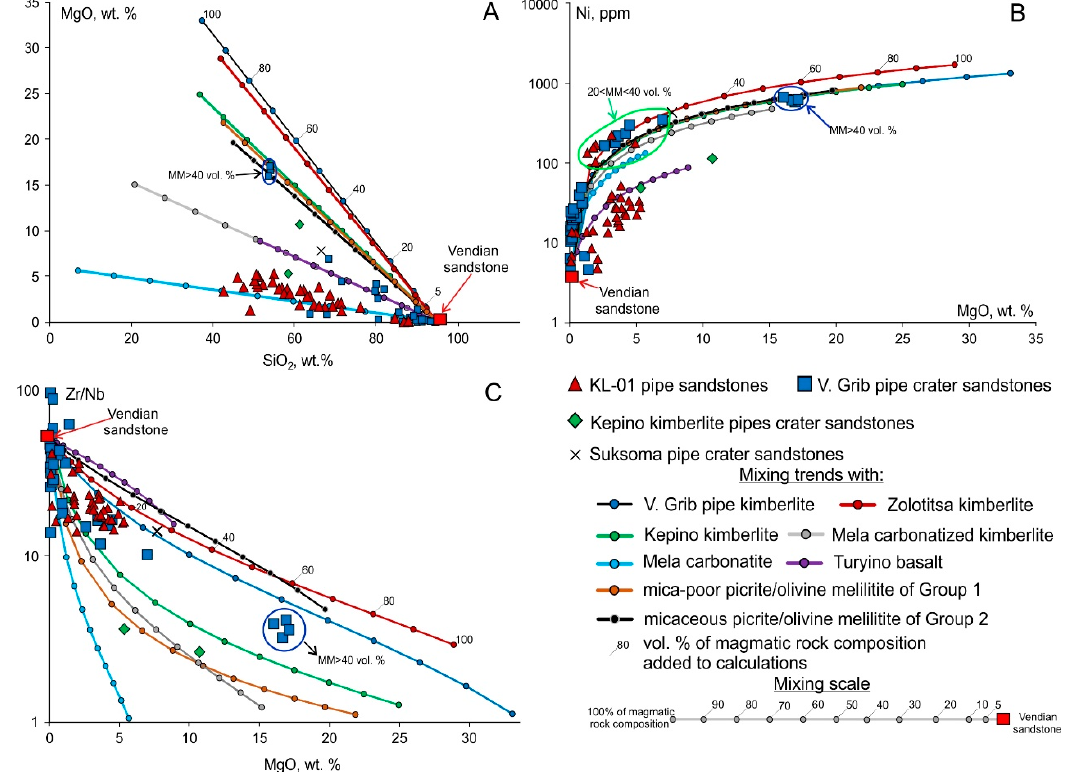
Figure 13. Trends of binary mixing between Vendian sandstones and typical ADP magmatic rocks based on correlations of MgO-SiO2 ( A ), Ni-MgO ( B ) and Zr/Nb-MgO ( C ). The end-members of mixing are the average compositions of Vendian sandstones and typical ADP magmatic rocks (Table S6).